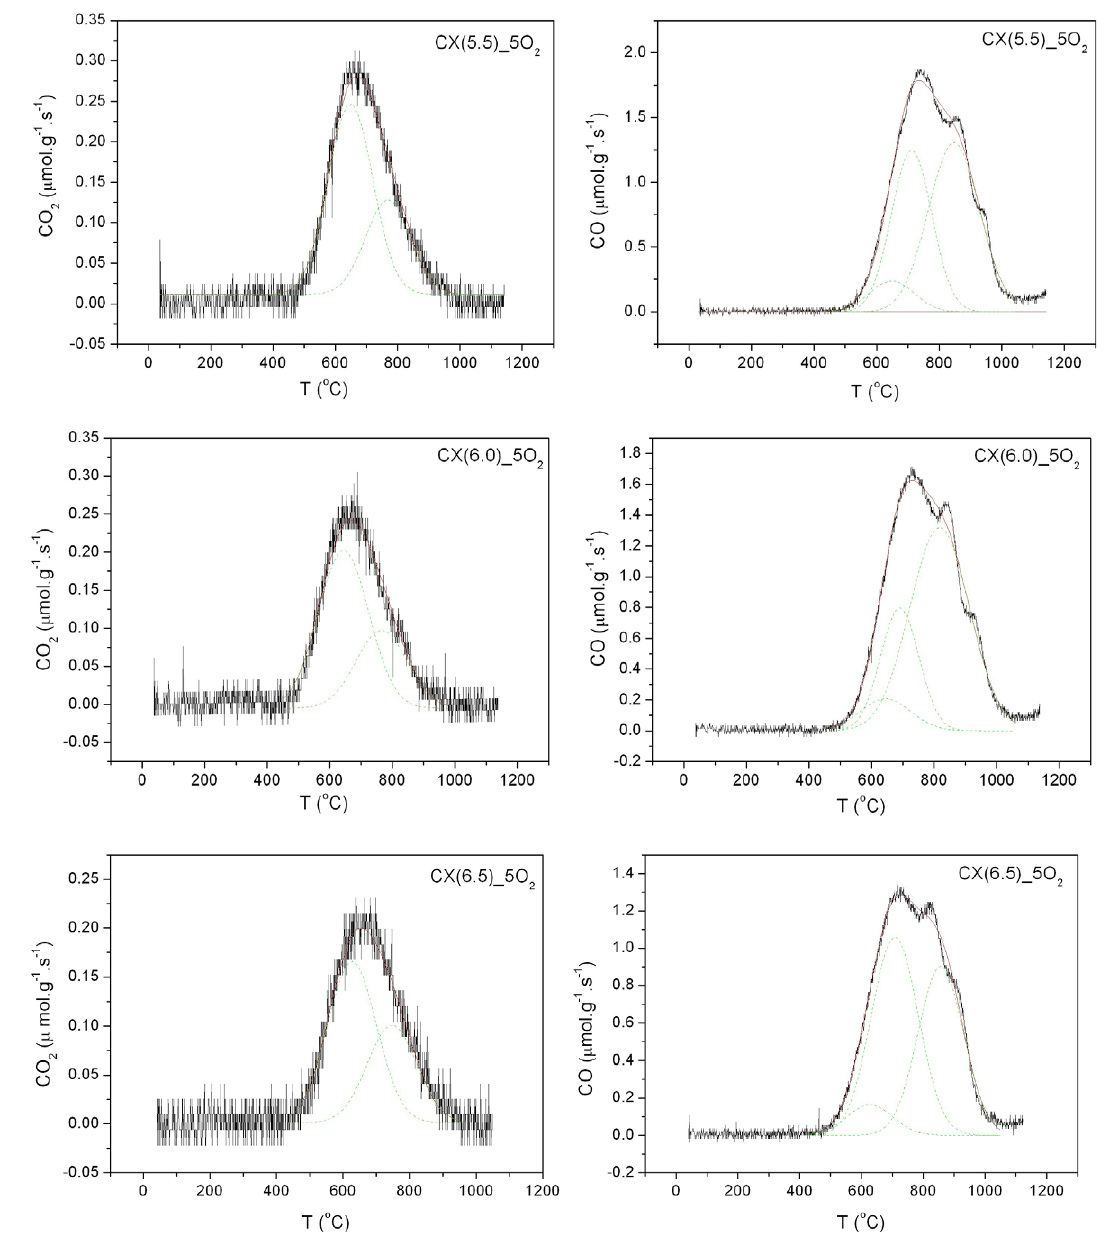
Figure 3. Deconvoluted TPD spectra of the activated carbon xerogels. Table 4. Results of the deconvolution of CO